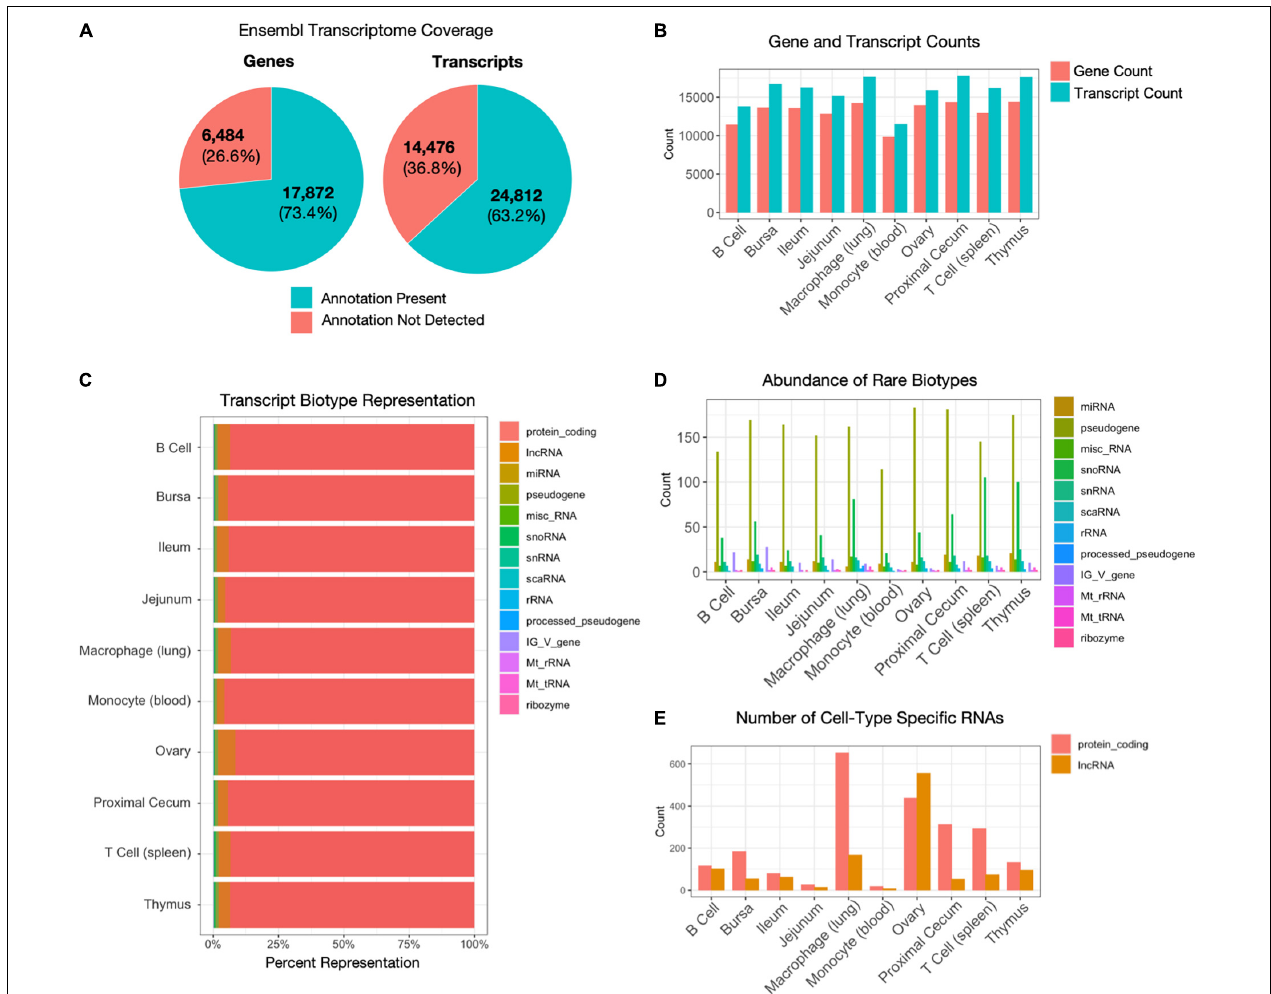
FIGURE 2 | Gene and transcript characterization. (A) Percentage of annotated chicken genes and transcripts detected across all samples. There are 24,356 genes and 39,288 transcripts in the Gallus gallus GRCg6a Ensembl annotation. (B) The number of genes and transcripts detected per cell type. Gene counts range between 9,839 [monocyte (blood)] – 14,418 [thymus]. Transcript counts range between 11,522 [monocyte (blood)] – 17,794 [proximal cecum]. (C) Breakdown of transcript types detected per cell type, by percentage. (D) Counts of low abundance transcript biotypes with less than 3% representation (all transcript biotypes, except lncRNA and protein-coding RNA). (E) The number of protein-coding RNAs and lncRNAs unique to each sample